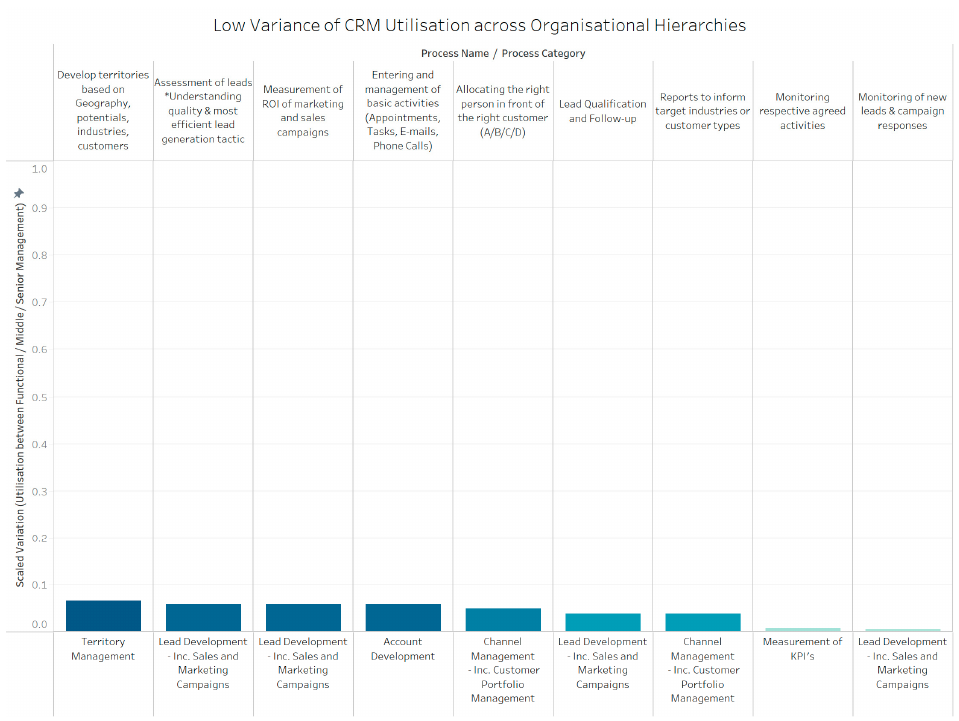
Figure 3. CRM Processes with a high variance of utilisation across organisational hierarchies, as developed for this study.